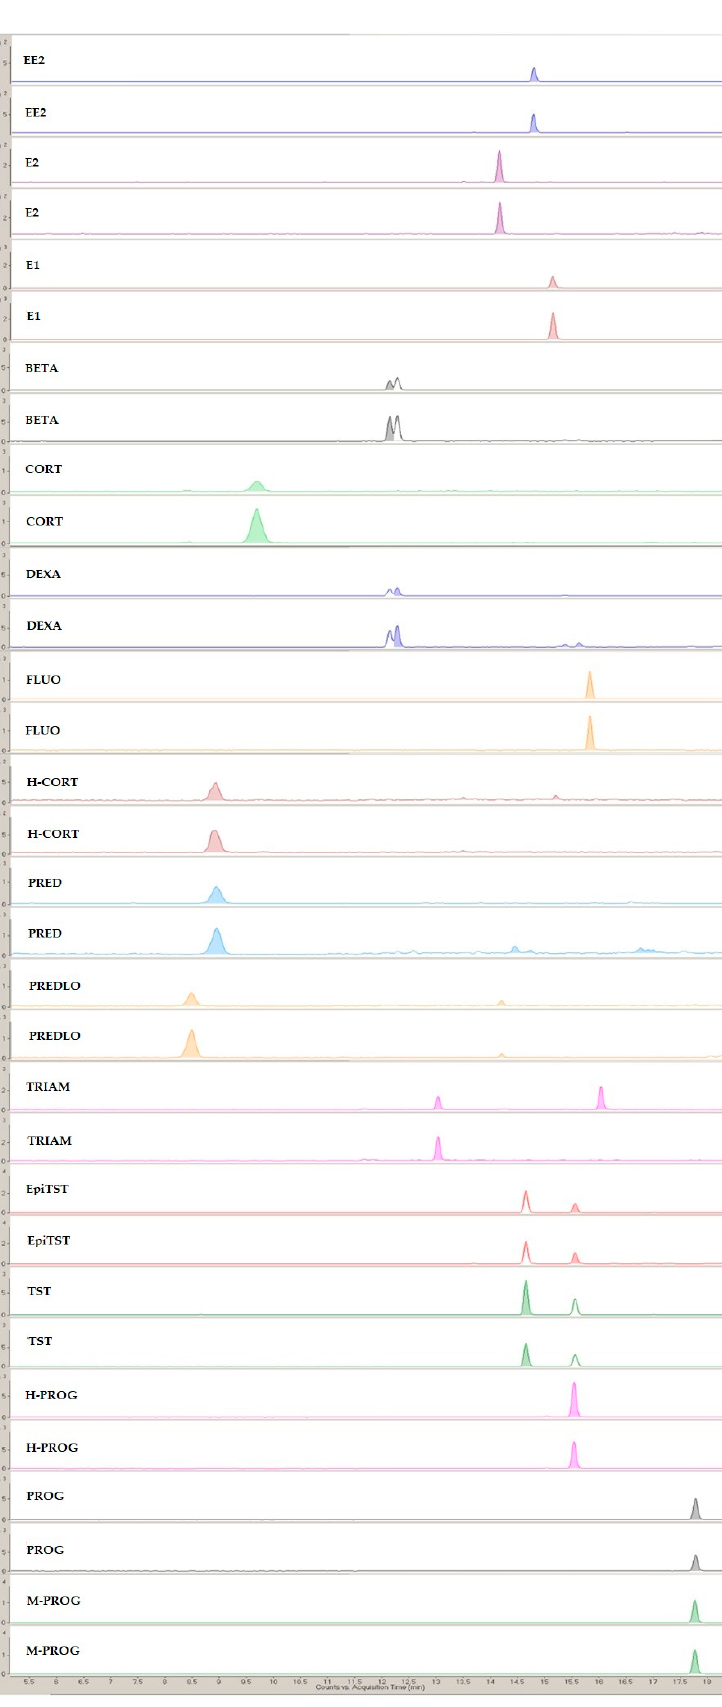
Figure 5. Representative MRM chromatogram from the analysis of the SPE lake eluates.